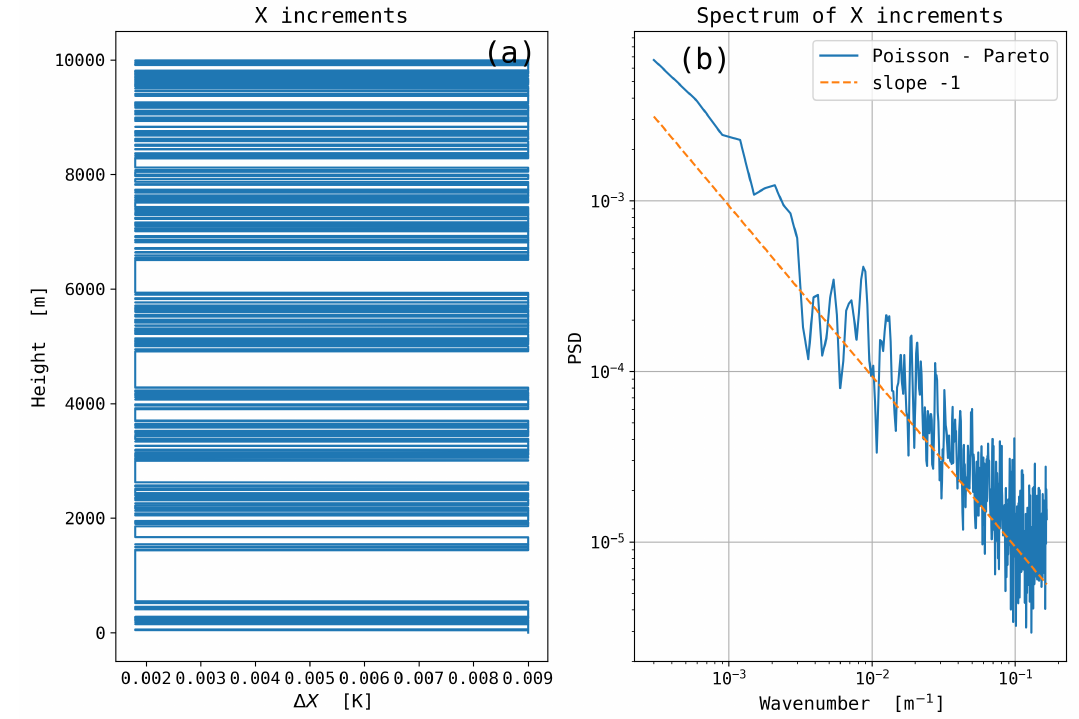
Figure A1. ( a ) A sequence of increments based on the Poisson-Pareto model (see text). ( b ) Power spectrum of the increments sequence. The straight line shows a − 1